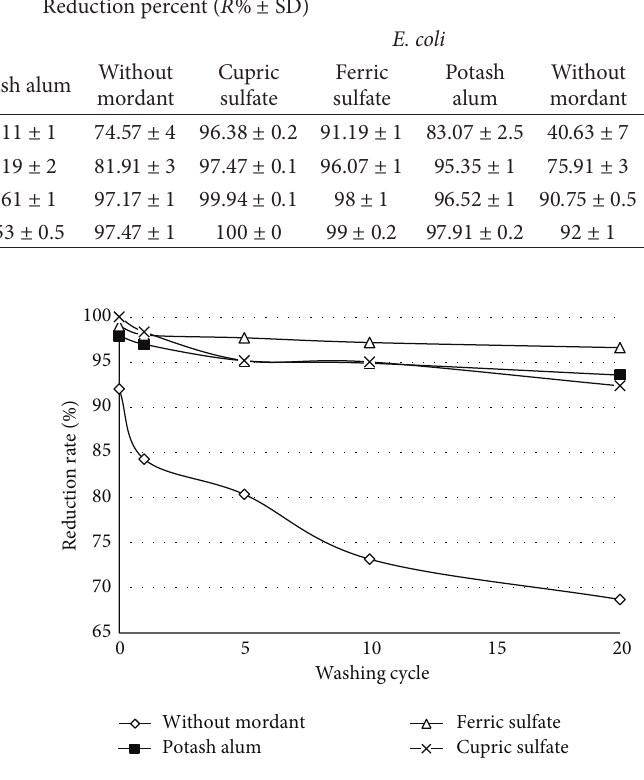
Figure8:Antibacterialactivityofdyedpolyamidesampleswith10% walnut dye against E. coli after